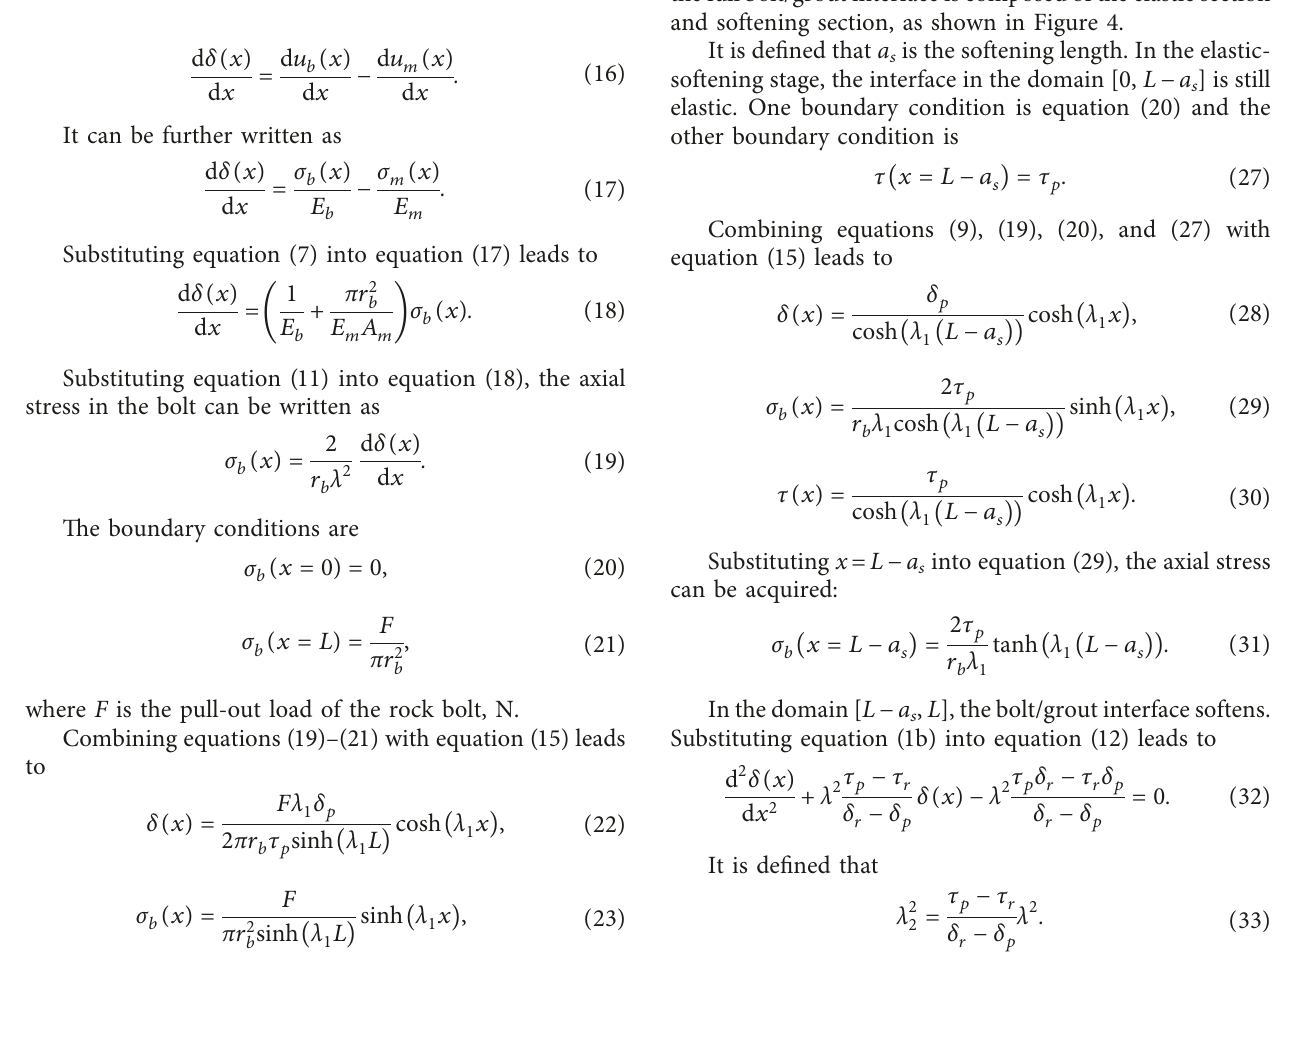
Figure 3: The full bolt/grout interface is elastic in the elastic stage where D b is the diameter of the rock bolt,